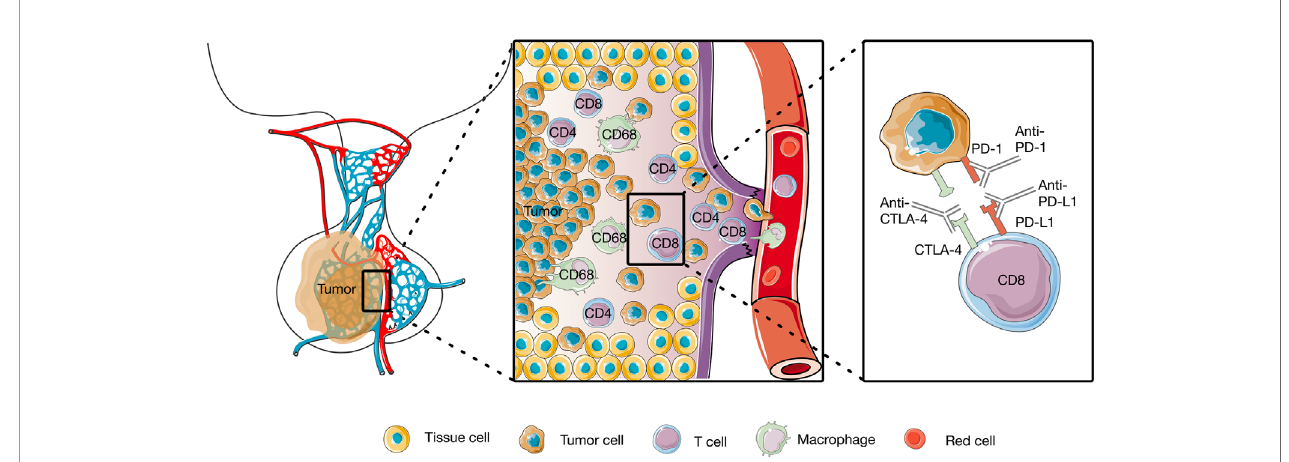
FIGURE 1 | Tumor immune microenvironment of pituitary tumors and of Working model of anti-PD1 and anti-anti-CTLA4. The CD4+, CD8+, and CD68+ cells were identi fi ed in pituitary tumors, and anti-PD1 and anti-anti-CTLA4 rescue T cell anti-tumor effector